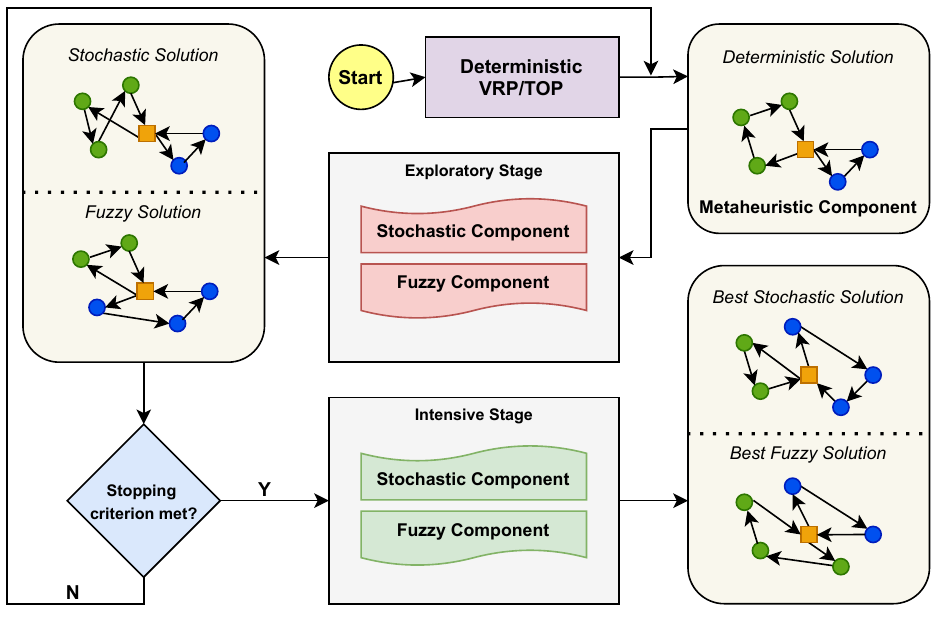
Figure 3. High-level flowchart of the proposed solution